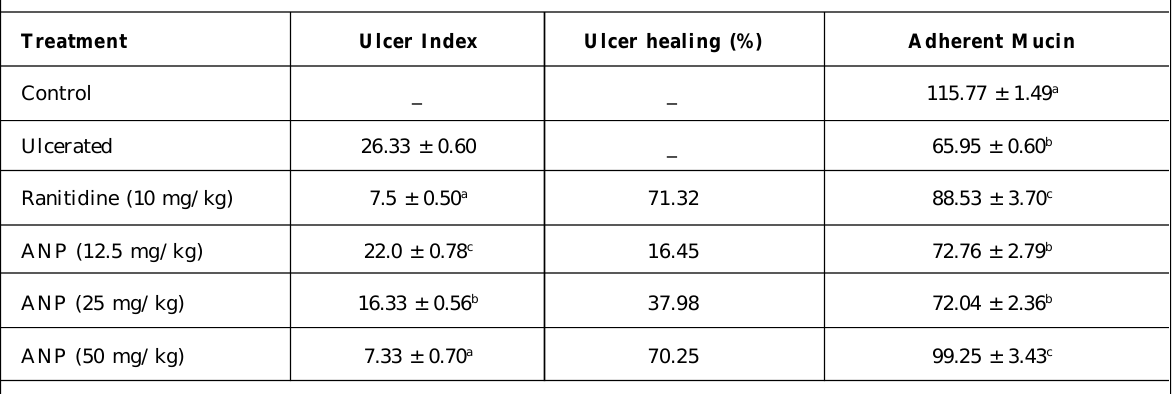
Note: Data are mean of 6 replicates ± SEM; values with different superscript are significantly different ( p < 0.05); ANP: Acacia nilotica seedpod. Table 3b: Effect of A. nilotica seedpod aqueous extract on gastric wall indices in ethanol - Induced ulcerated rats Treatment